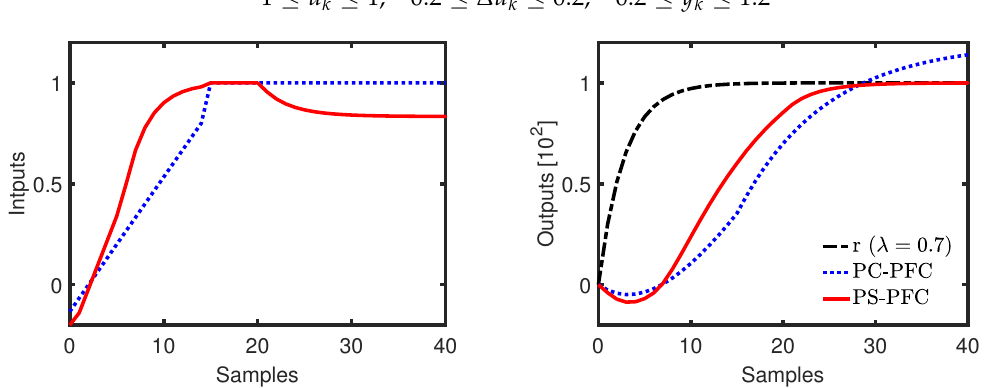
Figure 4. Constrained input and output behaviour of PFC, Pole Cancellation PFC (PC-PFC), and Pole Shaping PFC (PS-PFC) for processes G 1, G 2 , G 3 .